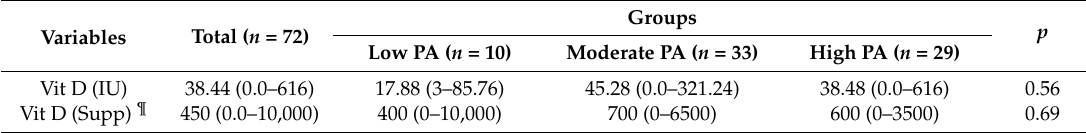
Table 4. Dietary and supplemental vitamin